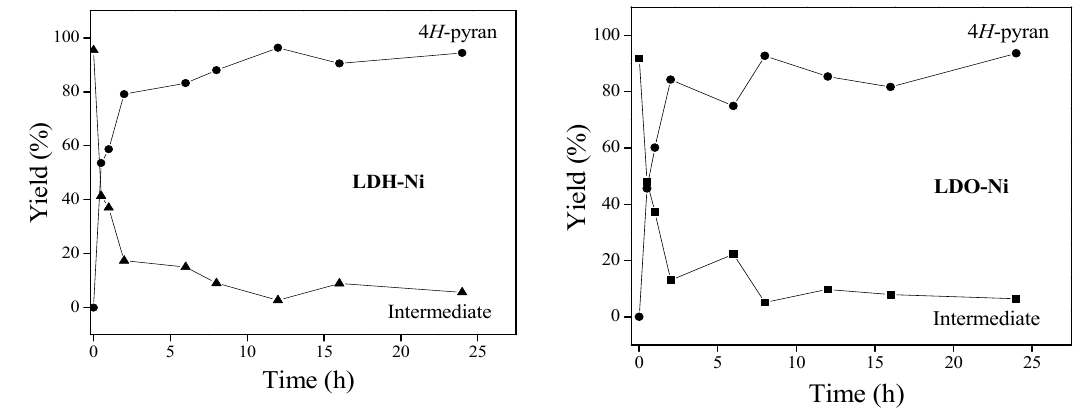
Figure 6. Reaction of 4 H -pyrans with LDH–Ni and LDO–Ni.